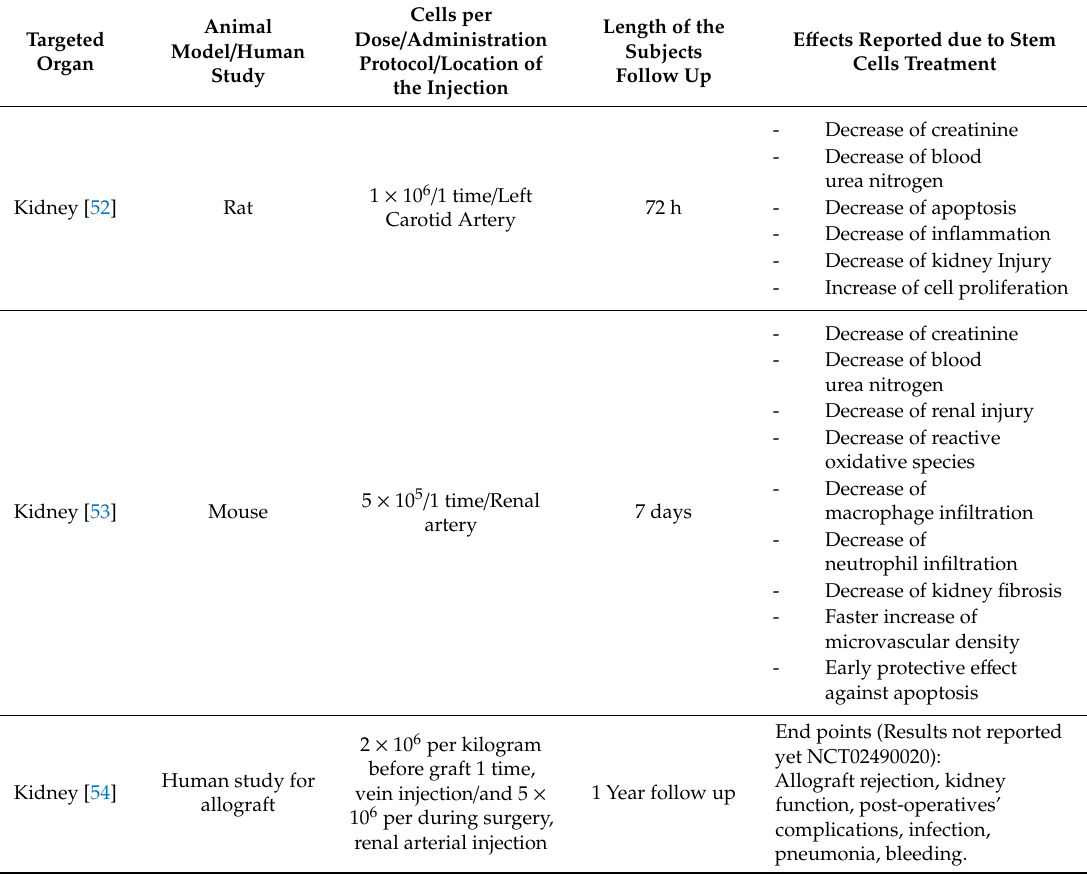
Table 3. Umbilical Cord Stem